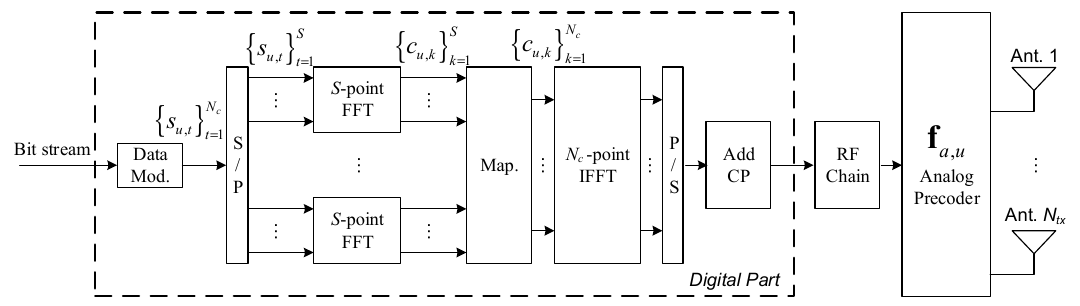
Figure 1. General block diagram of the u th user terminal.